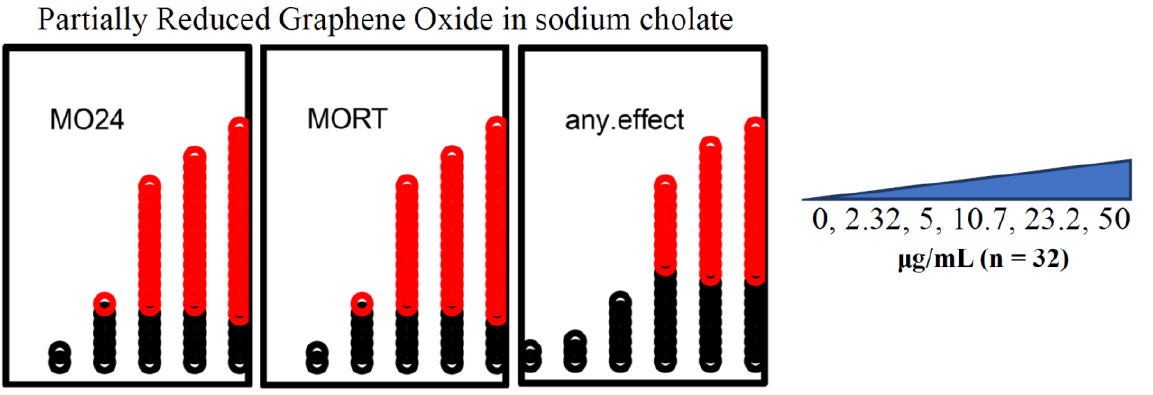
Figure 4. prGO developmental toxicity . Embryonic exposures to 0 μ g/mL, 2.32 μ g/mL, 5 μ g/mL, 10.7 μ g/mL, 23.2 μ g/mL, and 50 μ g/mL prGO ( n = 32) caused significant mortality at both 24 hpf and 120 hpf ( p < 0.05). The calculated LEL was 10.7 μ g/mL. MO24 = 24 hpf mortality; MORT = 120 hpf mortality; any.effect = physical malformations, including mortality at 120 hpf. Outcomes significantly above the binomial threshold (Student’s t -test; α = 0.05) are indicated in red on the dot plot. Table 2. Summary of Behavioral outcomes in response to GO exposures. Tabulated summary of the behavior effects that were recorded in graphical form (see Figures S2–S4) obtained when the embryos were 5 dpf. An asterisk (*) indicates that the activity level is dependent on the concentration that the embryos were exposed to at 6